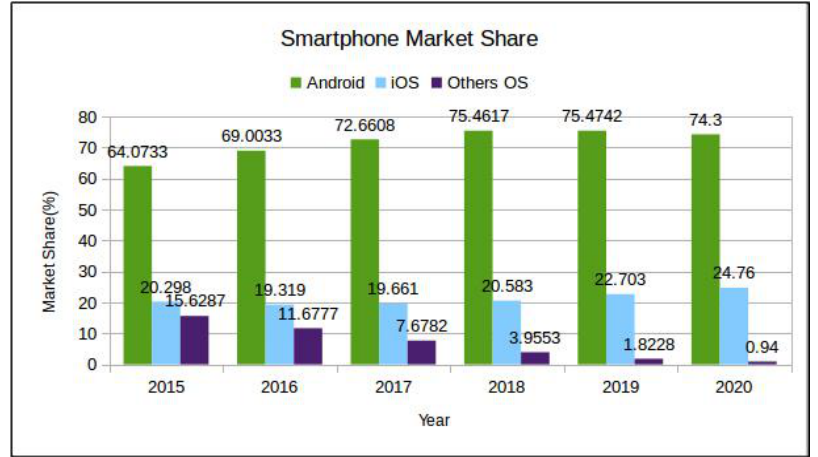
Figure 1. Smartphone Market Share 2015–20 [statcounter.com].